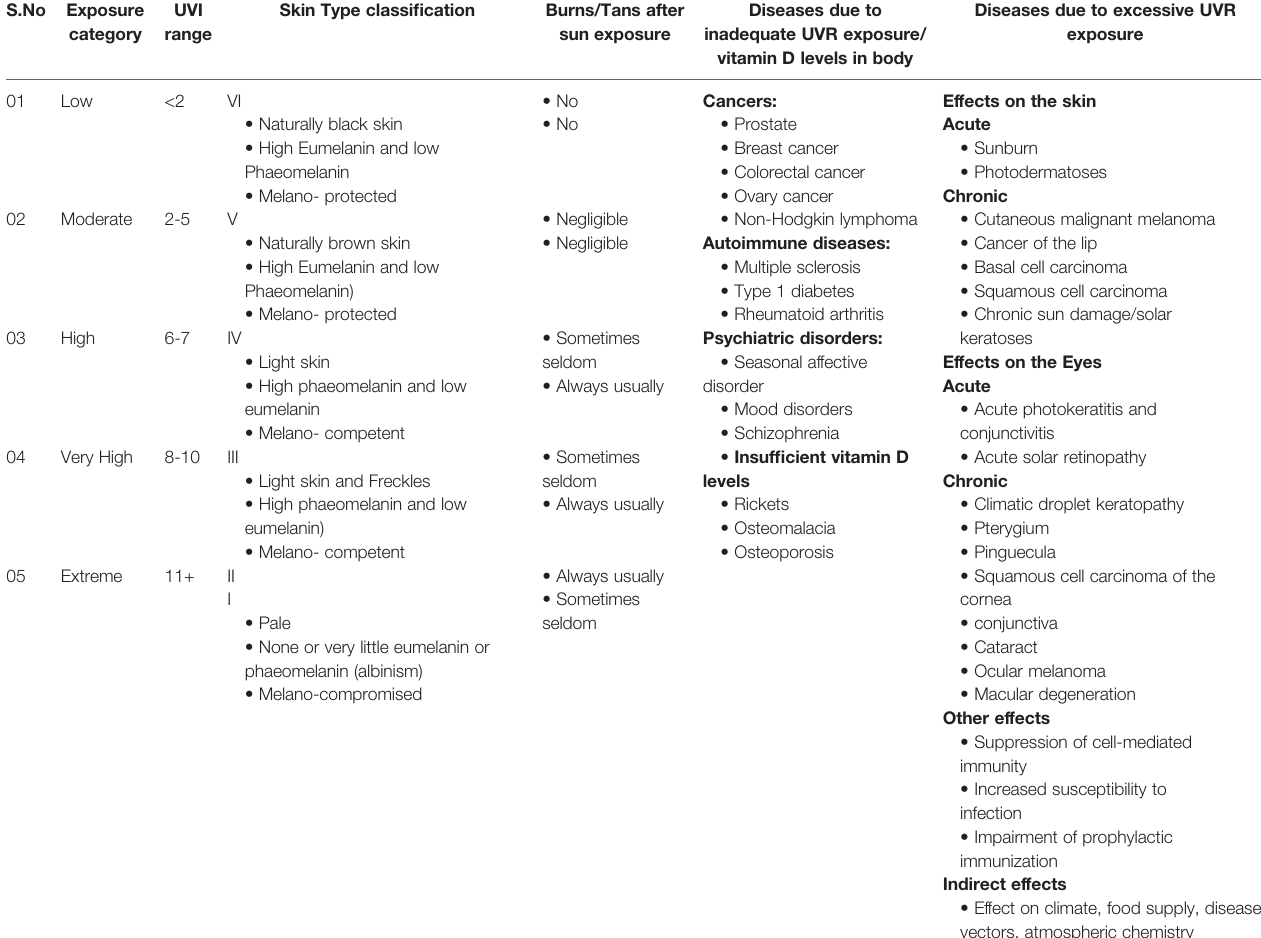
TABLE 1 | Classi fi cation of skin types/skin color types and burns/tans in the skin after sun exposure. S.No Exposure